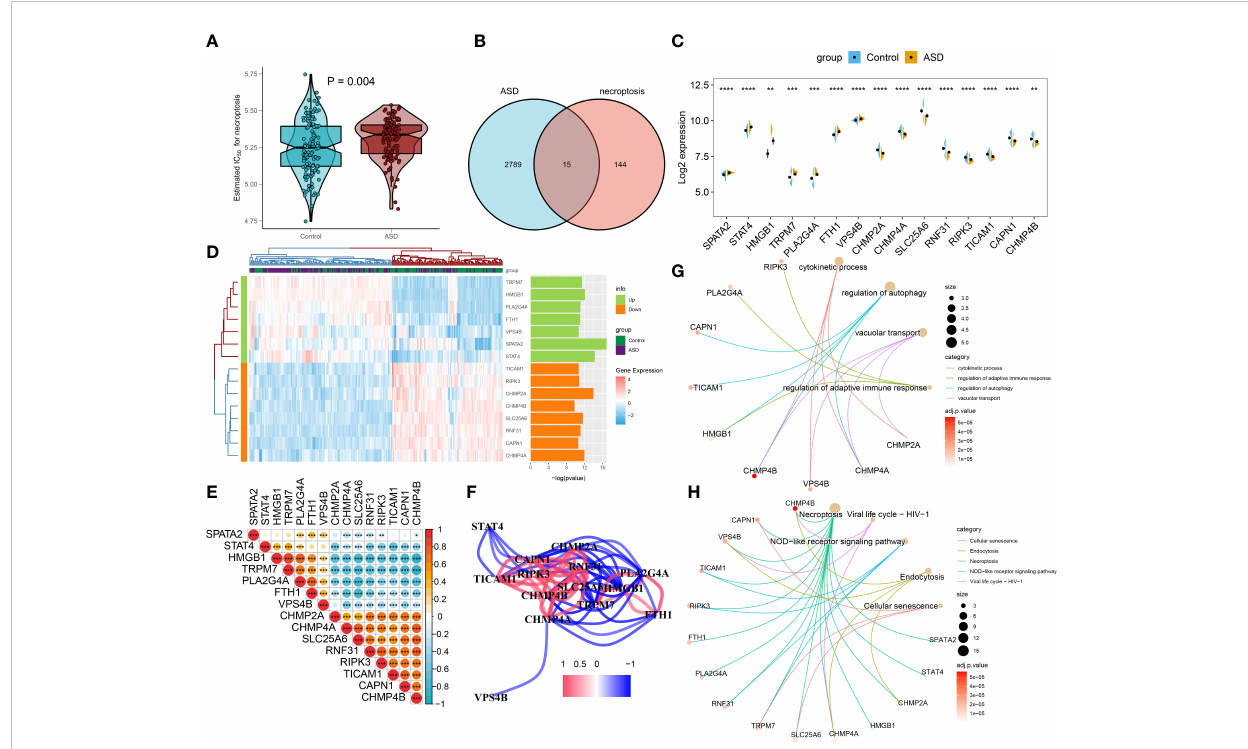
FIGURE 4 Identi fi cation of differential NRGs in ASD children. (A) Representative Venn diagram revealing the intersection of DEGs and obtained NRGs. (B – D) Representative volcano plot (B) , heatmap (C) , and split violin plots revealing the differentially expressed NRGs between healthy controls and ASD children. (E, F) Representative correlation plot (E) and network (F) of 15 differentially expressed NRGs. * p < 0.05, *** p < 0.001. (G, H) Representative results of GO : BP (G) and KEGG (H) enrichment analysis. **p < 0.01, and ****p <